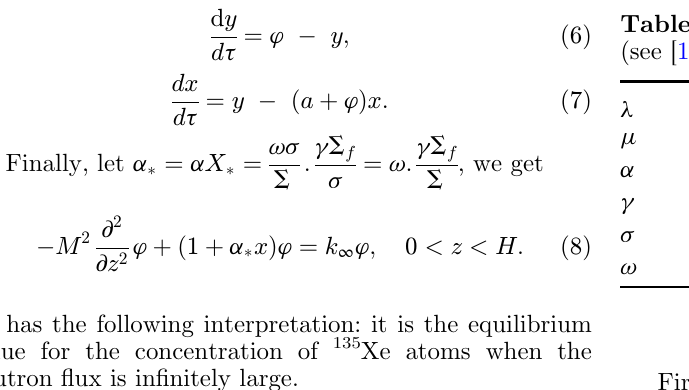
First step, solve